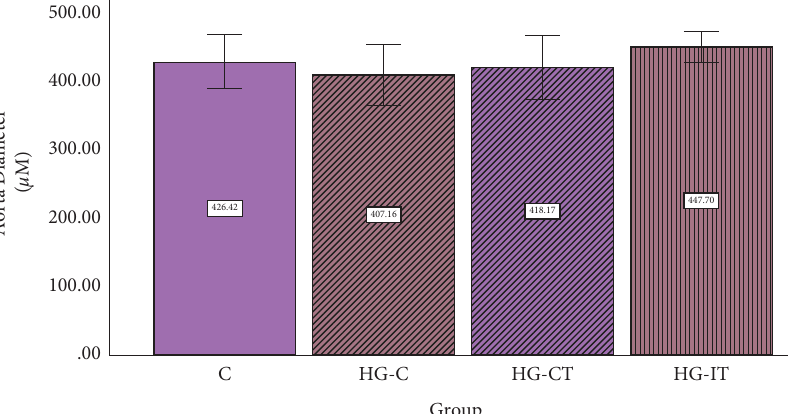
Figure 9: Aorta diameter within each group. c: control group; HG-C: hyperglycemic control group; HG-CT: hyperglycemic rats that performed moderate-intensity continuous training (MICT); HG-IT: hyperglycemic rats that performed high-intensity interval training (HIIT). Te error bars represent the standard deviation of measurements.